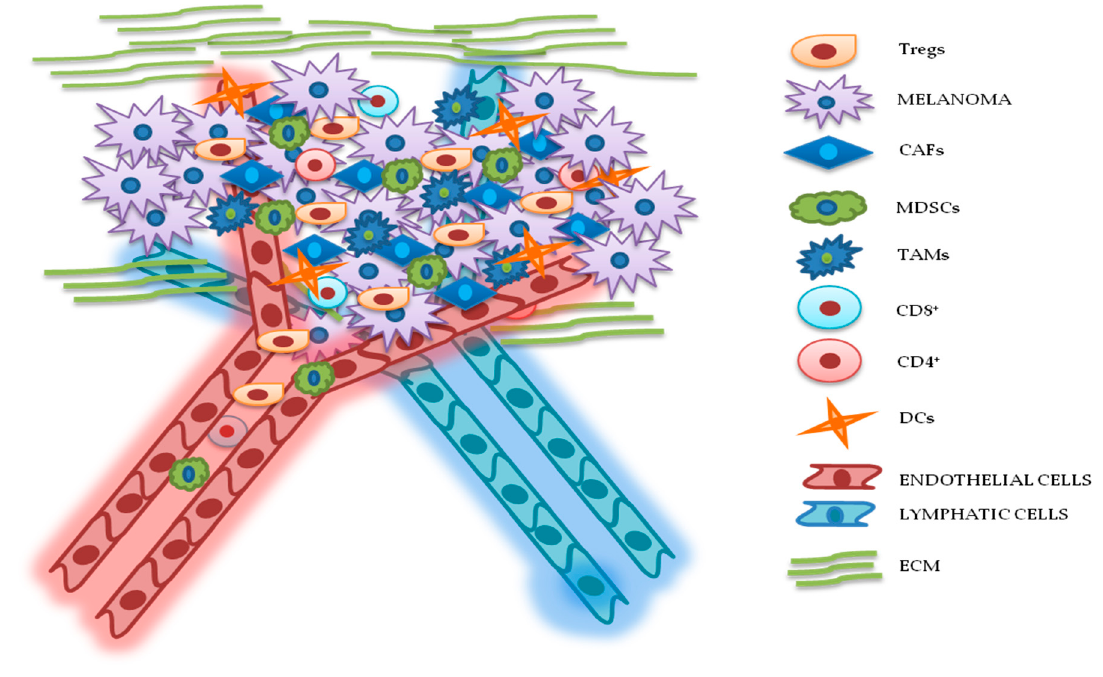
Figure 2. Relationship between melanoma and tumor microenvironment (TME). In this figure, is illustrated schematically the reciprocal interactions between melanoma cells and the other components of TME. Melanoma’s TME, involved in tumor growth, progression, and drug resistance, is essentially represented by regulatory T cells (Tregs), cancer-associated fibroblasts (CAFs), myeloid-derived suppressor cells (MDSCs), tumor-associated macrophages (TAMs), cluster di ff erentiation (CD) 4 + / CD8